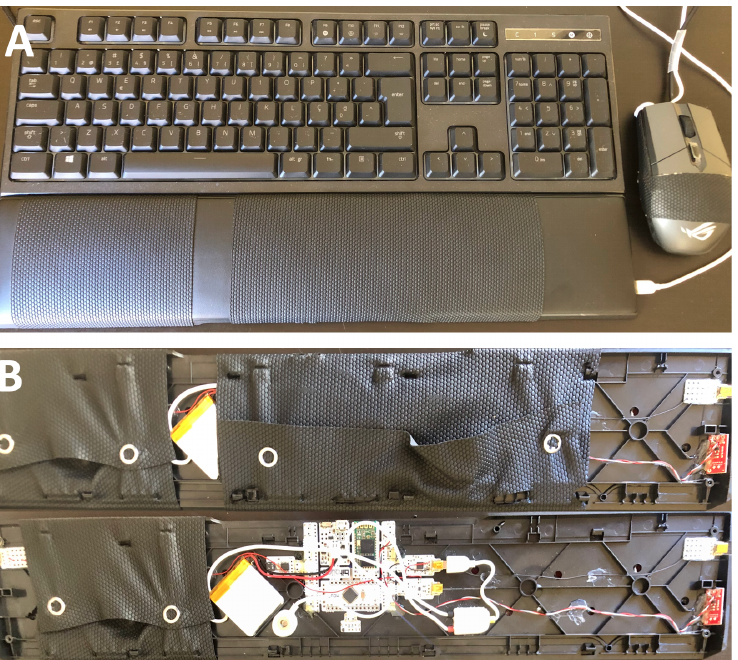
Figure 1. Prototype of the keyboard armrest, highlighting ( A ) the positioning of the electrodes and ( B ) the data acquisition